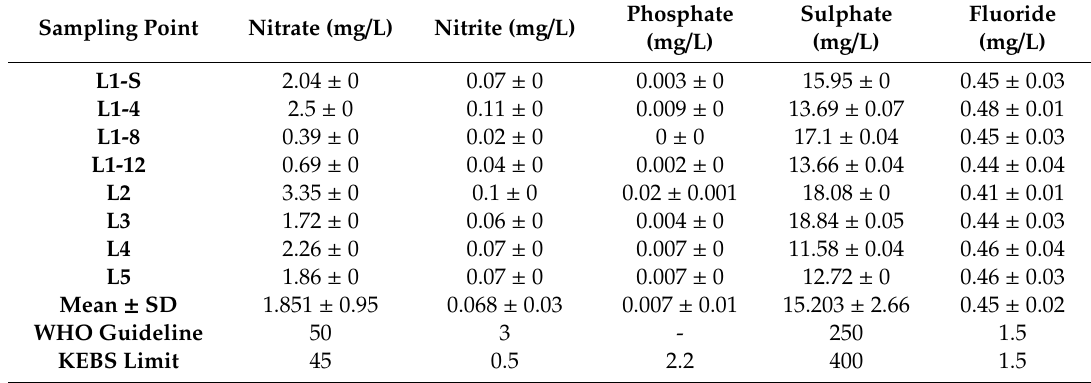
Table 9. Concentration of chemical parameters in Rungiri quarry reservoir in January